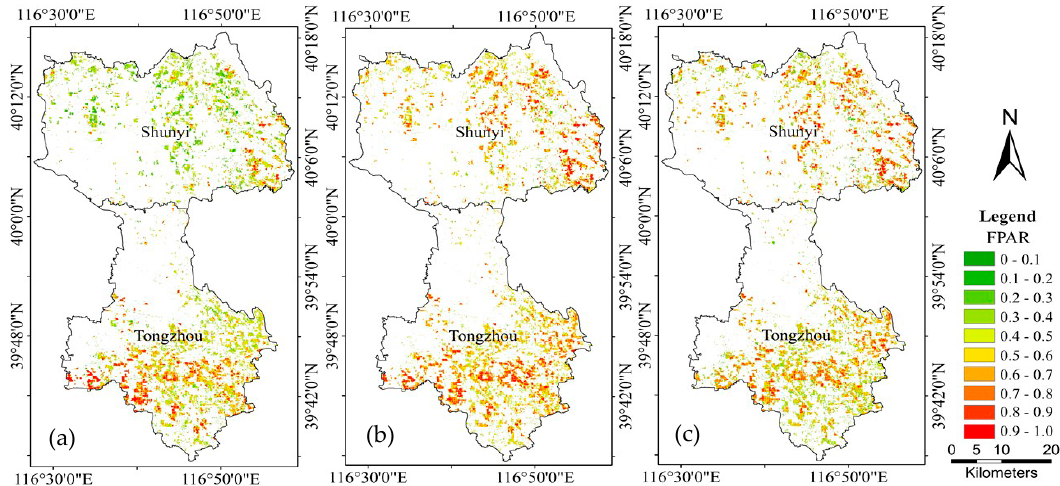
Figure 3. Spatial distribution of winter wheat fPAR from March to May, 2009: ( a ) March; ( b ) April; ( c ) May.